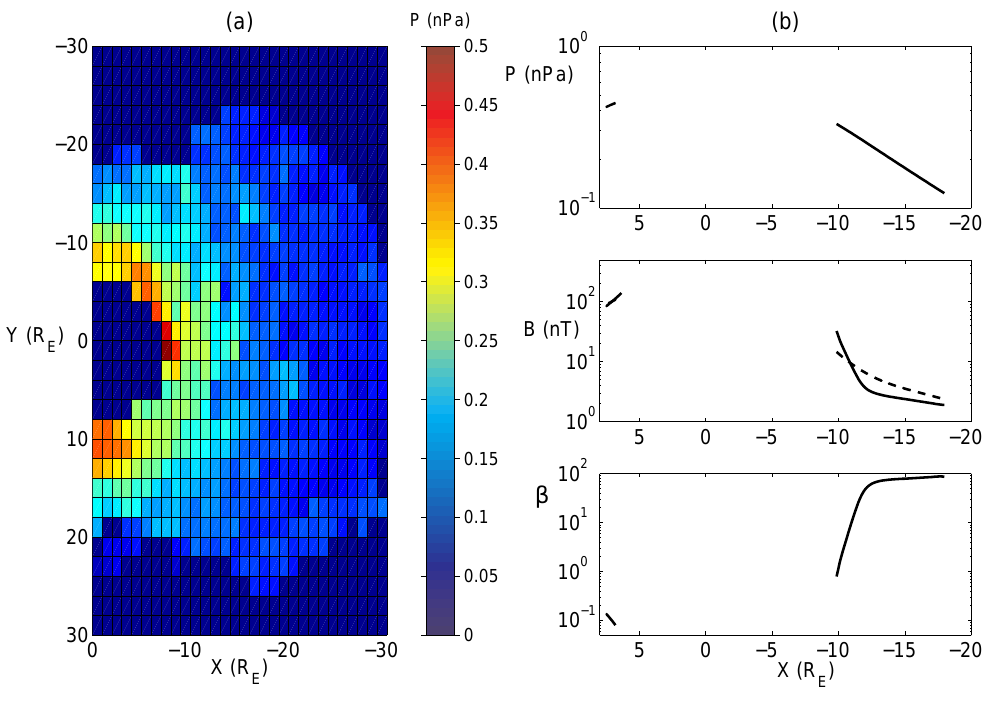
Fig. 7. (a) GEOTAIL plasma sheet pressure data for times of low magnetospheric activity (0 < K p < 1); (b) Sun-Earth axis profiles of P , | B | and β for the computation with GEOTAIL plasma sheet pressure; the dashed line in the second plot represents | B | from the T96